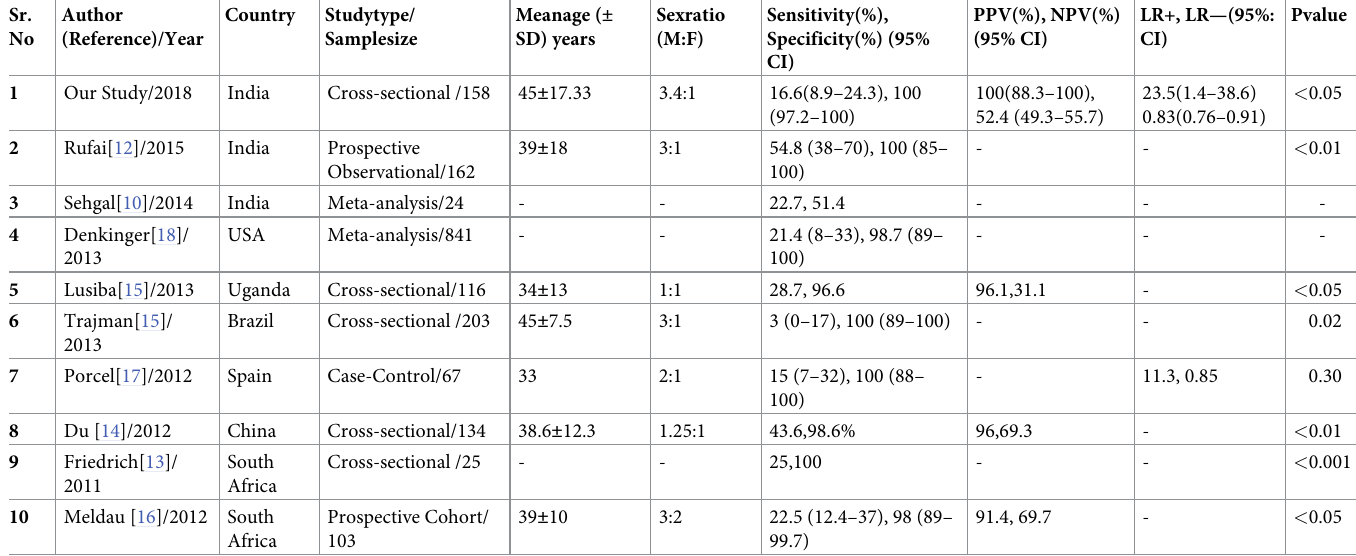
Table 4. Comparison with previous studies conducted on the diagnostic utility of tuberculosis assay in detecting tubercular pleural effusion. Sr.